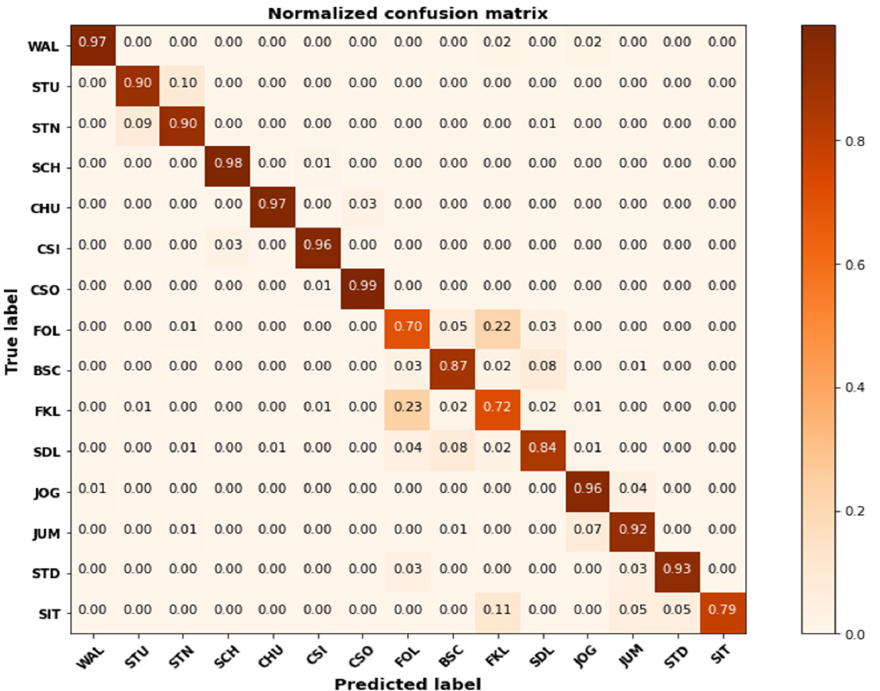
Figure 11. Real-Life HAR: individual ROC curves for all the classes, class 1 = walking, class 2 = active, class 3 = inactive, class 4 = driving.